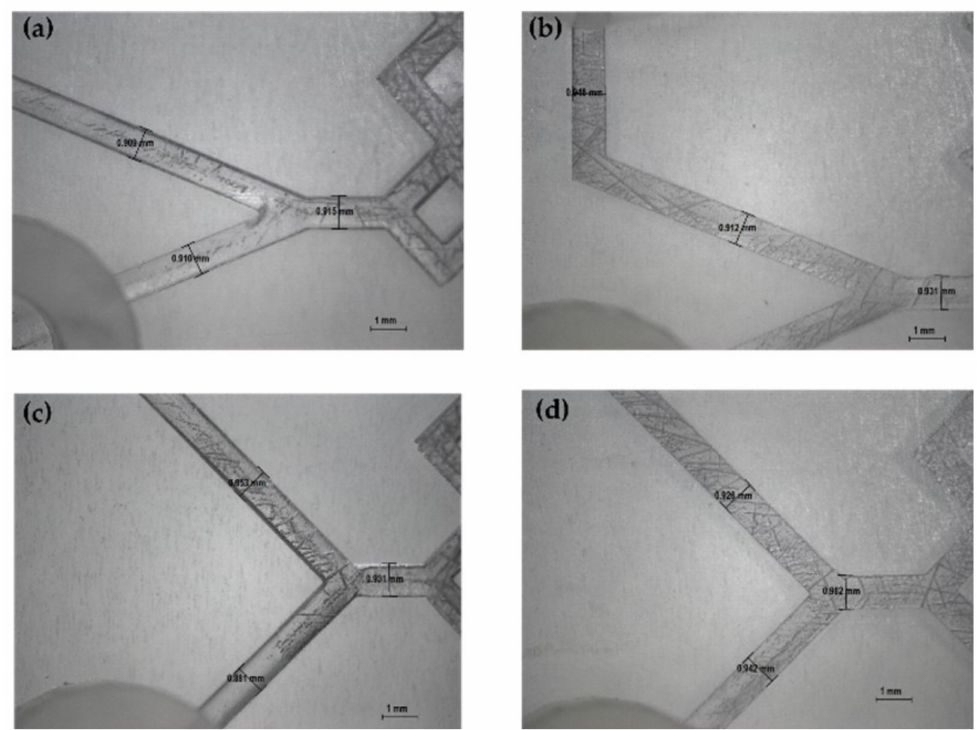
Figure 4. Optical microscope images of DLP 3DP devices (8 × ). ( a ) Inlet’s image of device 2.